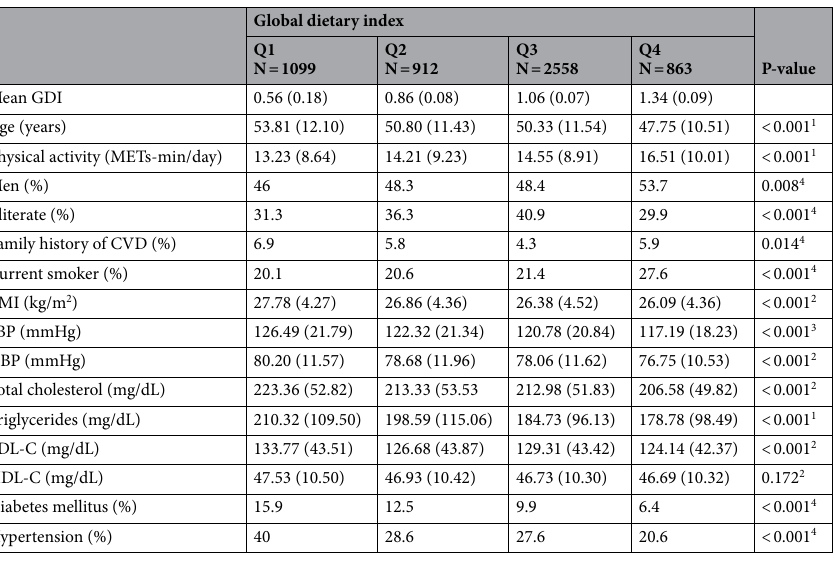
Table 5. Baseline characteristics in participants by quartiles of global dietary index. GDI global dietary index, BMI body mass index, SBP systolic blood pressure, DBP diastolic blood pressure, LDL-C low density lipoprotein cholesterol, HDL-C high density lipoprotein cholesterol. 1 Obtained from Kruskal–Wallis test. 2 Mean comparison obtained from ANOVA test. 3 Obtained from Brown-Forsyth test. 4 Frequency comparison obtained from Chi-Square.